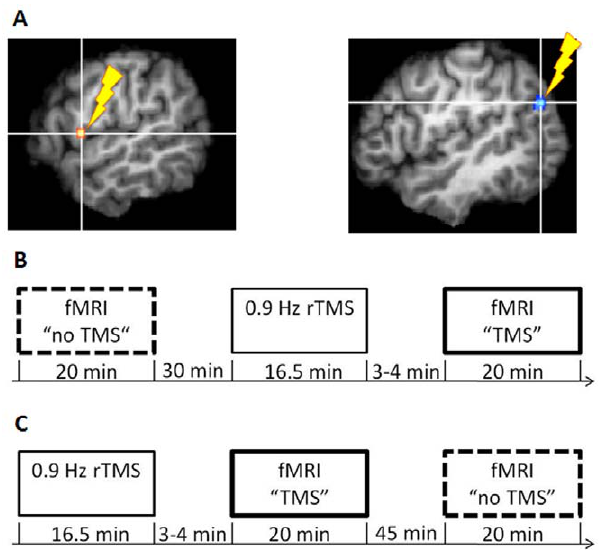
Figure 2. Stimulation sites and session procedure. A: Each subject participated in two rTMS-fMRI sessions separated by one week, in which rTMS was performed either over the left PMv or the left AG (rTMS control), respectively. The stimulation sites were chosen on the basis of Kornysheva et al. [59]. B: In one half of the subjects, each session started with an fMRI scan not preceded by rTMS (‘‘fMRI no TMS’’ first), C: in the other half the fMRI scan following rTMS came first (‘‘fMRI TMS’’ first)). In the latter case, the second fMRI scan (‘‘no TMS’’) was performed following a 45 minutes interval, during which the subjects stayed in a room adjacent to the MRI scanner